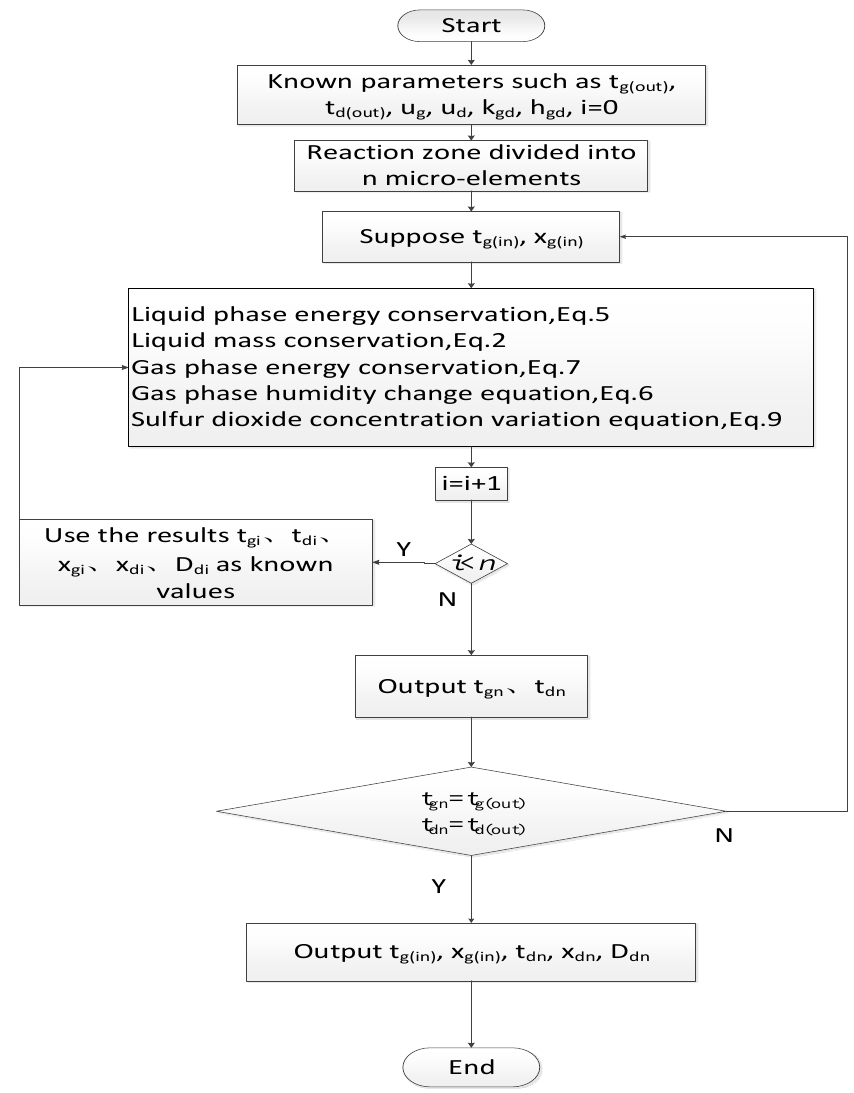
Figure 2. Numerical calculation flow chart of desulfurization tower. The working media and structural parameters of the desulfurization tower involved in solving the model are shown in Table